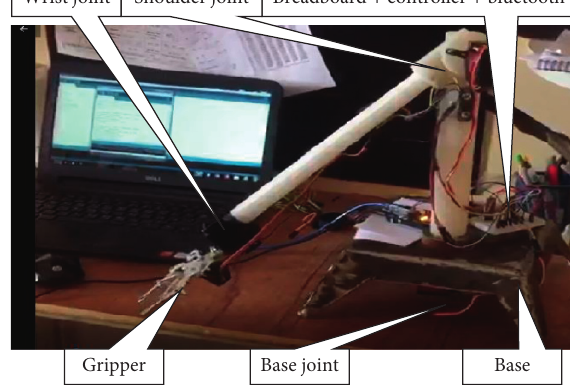
Figure 6: Developed 3-DOF robot.